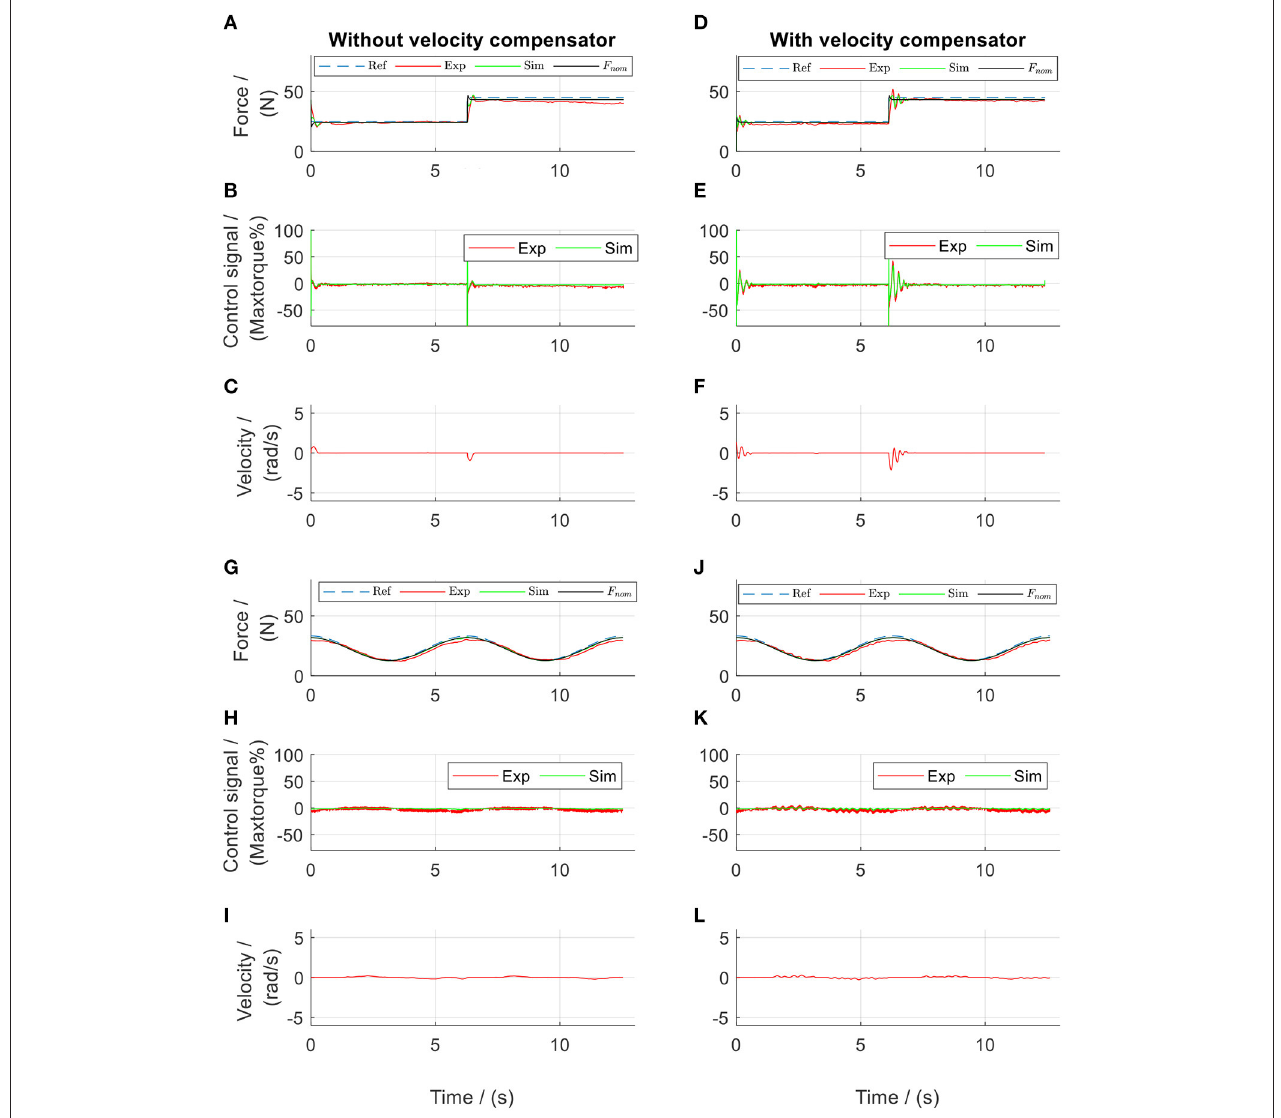
FIGURE 10 | Lead algorithms regulated force control of the front thigh actuator in the static tests. Subplots (A–F) show the results from square-wave reference test, while subplots (G–L) show the results from sinusoidal reference test. Ref, references; Exp, experimental values; Sim, simulation results; F nom , the simulated